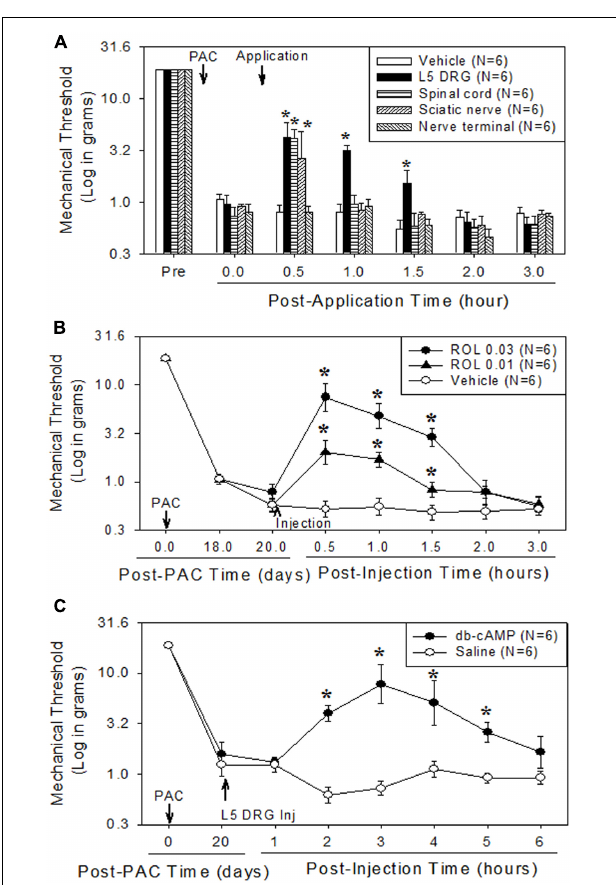
FIGURE 1 | Comparison of the analgesic effect of local administration of rolipram (ROL) to the L5 DRG, spinal cord, sciatic nerve, and skin nerve terminal on established paclitaxel-induced neuropathic pain in rats. Paclitaxel (PAC, 2 mg/kg) was injected intraperitoneally in rats on four alternate days (days 0, 2, 4, and 6). Subsequently, the mechanical pain thresholds were significantly reduced. (A) [Analgesic effect of rolipram administered locally at four sites.] After the pain behavior was fully developed (20 days), 0.03 mg of rolipram was locally administered at four different sites. Local administration of rolipram at the L5 DRG significantly increased the mechanical pain threshold at 0.5, 1, and 1.5 h after administration. Vehicle was locally administered in the L5 DRG. Asterisks ( ∗ ) indicate significant differences ( P < 0.05) from baseline as determined using a one-way ANOVA with one repeated factor followed by Dunnett’s multiple comparison test. (B) [Effect of local administration of rolipram in the L5 DRG] On the 20th post-paclitaxel injection day, the rats were divided into three groups (Vehicle, ROL 0.01, and ROL 0.03). Rats were administered vehicle (3% DMSO in olive oil, 10 µ l), 0.01 mg of rolipram, or 0.03 mg of rolipram (indicated by the upward arrowhead), respectively. Administration of 0.03 mg of rolipram significantly increased the mechanical threshold at 0.5, 1, and 1.5 h. Asterisks ( ∗ ) indicate significant differences ( P < 0.05) from vehicle group as determined using a two-way ANOVA with one repeated factor (time) followed by Sidak’s multiple comparison test. (C) [Effect of local administration of db-cAMP in the L5 DRG] On the 20th post-paclitaxel injection day, the rats were divided into two groups (Saline, db-cAMP). Rats in each group were administered saline or 0.05 mg of dibutyryl cAMP (db-cAMP, indicated by the upward arrowhead), respectively, in the L5 DRG. Administration of 0.05 mg of db-cAMP significantly increased the mechanical threshold at 2, 3, 4, and 5 h. Data are expressed as mean ± SEM. Asterisks ( ∗ ) indicate significant differences ( P < 0.05) from saline group as determined using a two-way ANOVA with one repeated factor (time) followed by Sidak’s multiple comparison